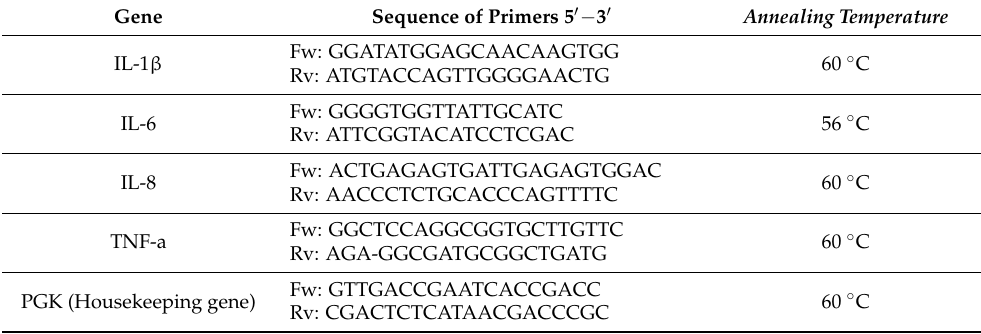
Table 2. Primers